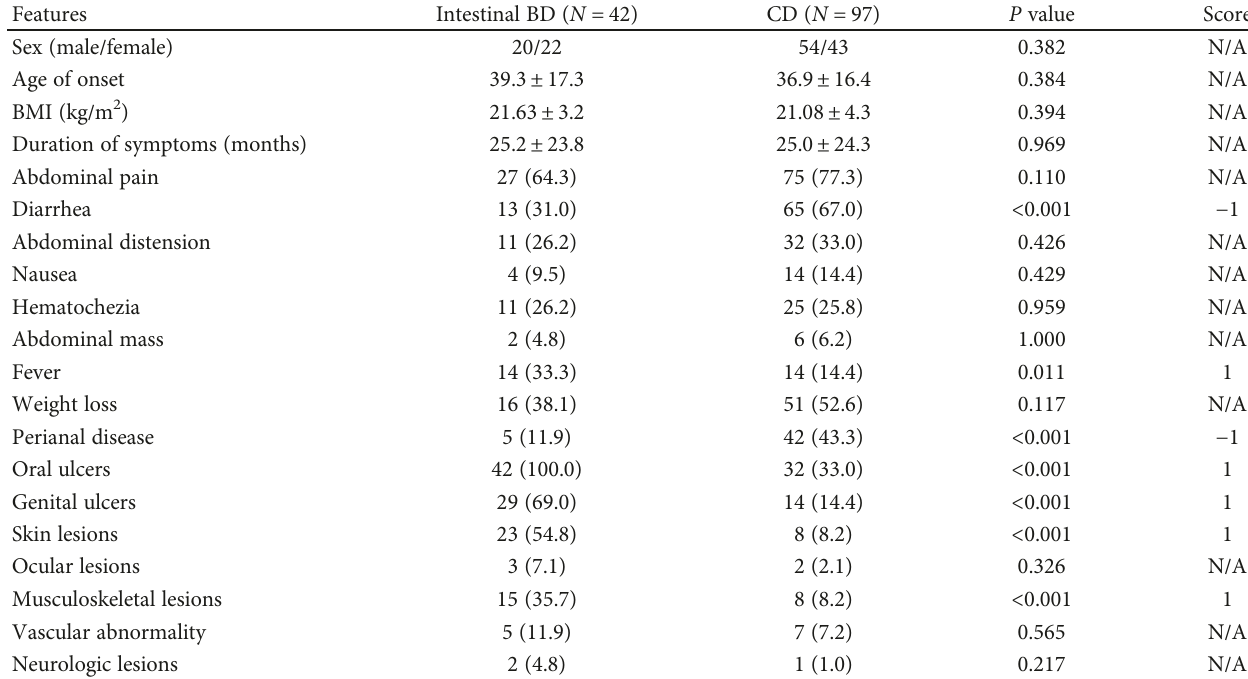
Table 1: Demographic characteristics and clinical manifestations of intestinal BD and